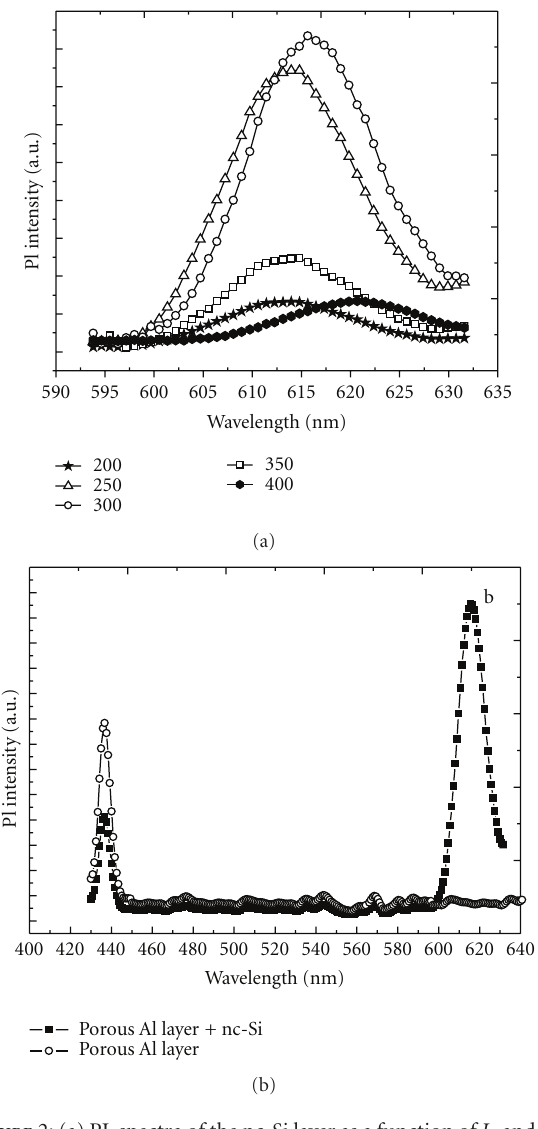
Figure 2: (a) PL spectra of the nc-Si layer as a function of I a and (b) typical PL spectrum of nc-Si films compared to PL response of the porous Al layer.